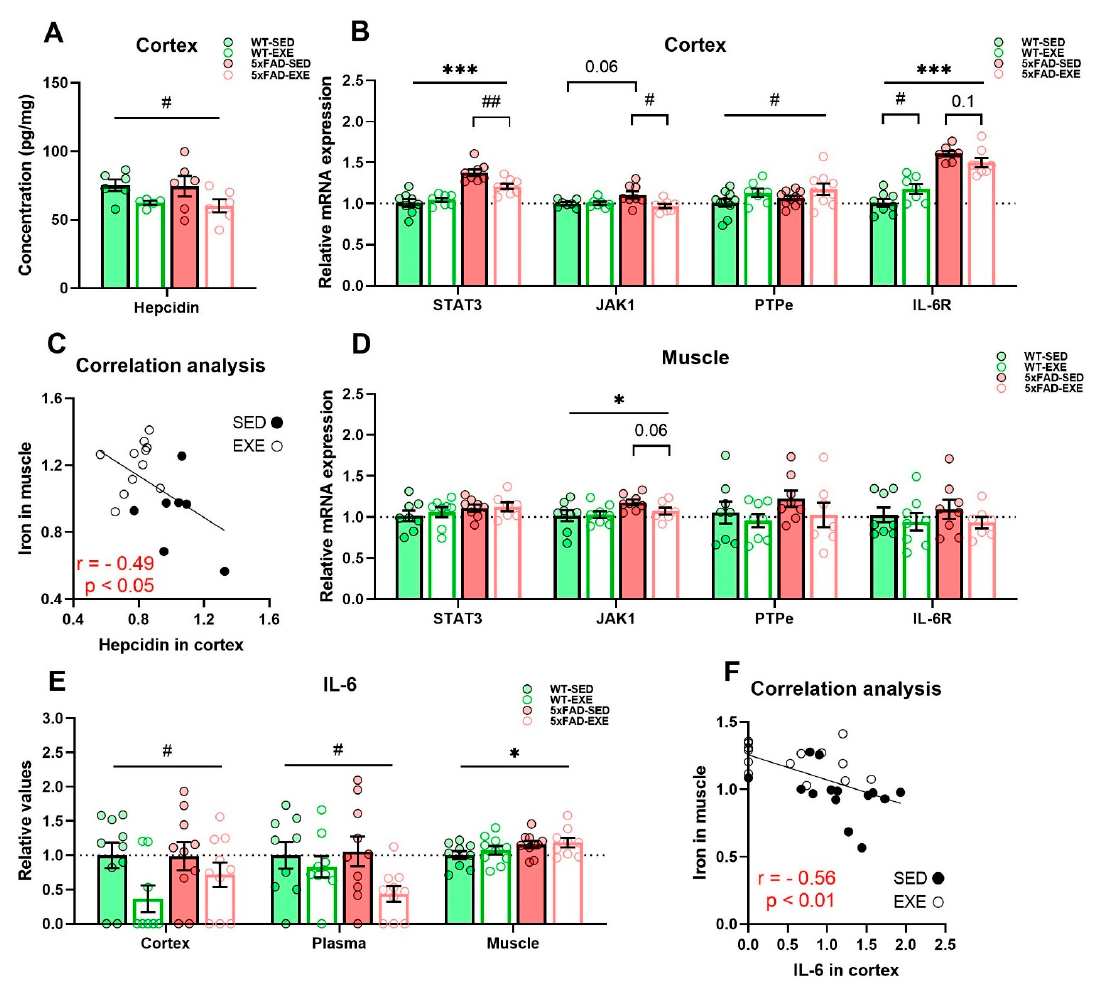
Figure 4. Effects of regular exercise on iron homeostasis regulation in cortex and muscle tissues in 5xFAD mouse model. ( A ) Hepcidin level in cortex was measured by ELISA and normalized to total protein concentration. ( C ) Correlation analysis for total iron content in muscle and hepcidin level in cortex was performed for all mice, r–Pearson correlation coefficient. mRNA expression of STAT3, JAK1, PTPe, and IL-6R in cortex ( B ) and muscle ( D ) was measured by qPCR. ( E ) IL-6 level in cortex, plasma, and muscle protein samples was measured by CBA. ( F ) Correlation analysis for total iron content in muscle and IL-6 level in cortex was performed for all mice. All data are presented as mean ± SEM. n = 6–10/group. «*» genotype effect, « # » exercise effect: *** p < 0.001, * p < 0.05, ## p < 0.01, # p < 0.05. General genotype/exercise effect among all groups is presented as a line with «*»/« # » sign on top, exercise effect in 5xFAD or WT mice separately is presented as a bracket with « # » sign/p value on top, genotype effect in SED mice only is presented as a bracket with p value on top.